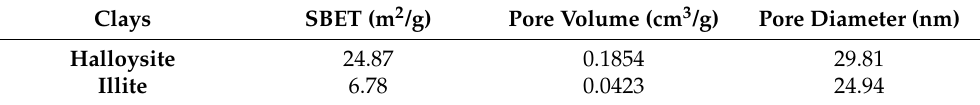
Figure 4. The adsorption–desorption isotherms of halloysite and illite. Table 1. Specific surface area, pore volume and pore diameter (nm) of halloysite and illite.